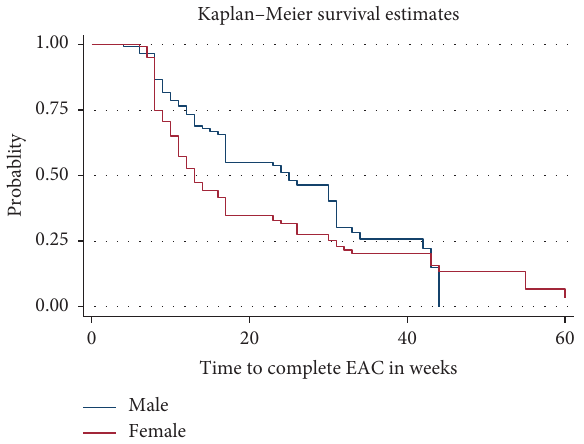
Figure 2: Kaplan–Meier survival curves showing failure experi- ences of patients who completed EAC by